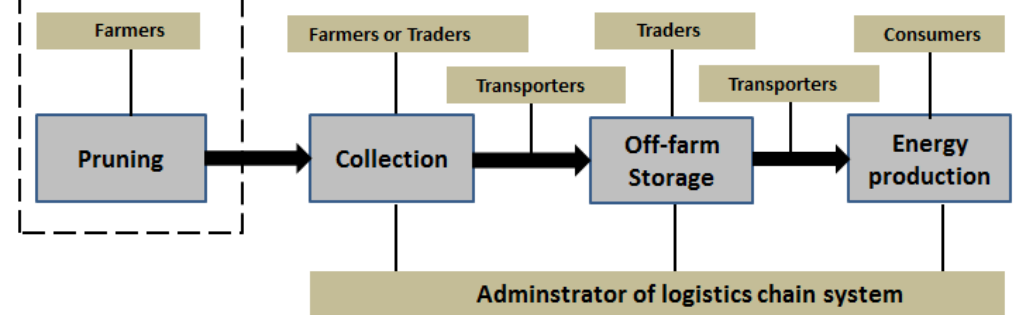
Figure 1. Different actors along the pruning biomass logistics chain.